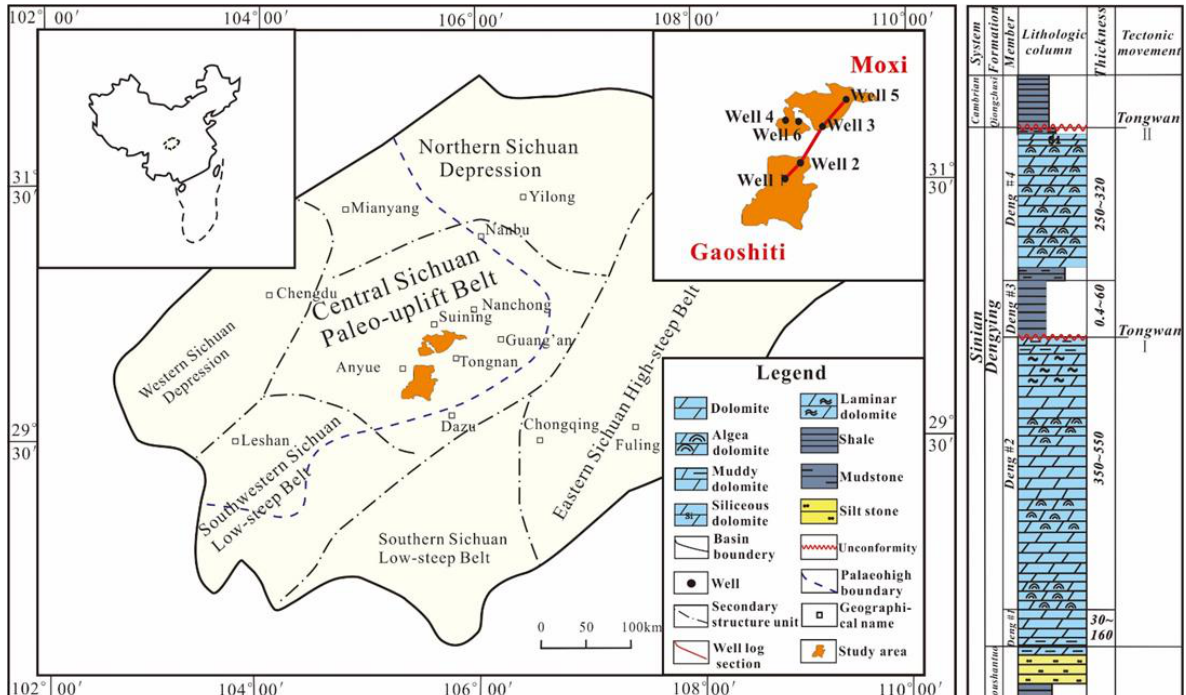
Figure 1. Location map of the study area and schematic of the lithology profile of the Sinian Dengying Formation.